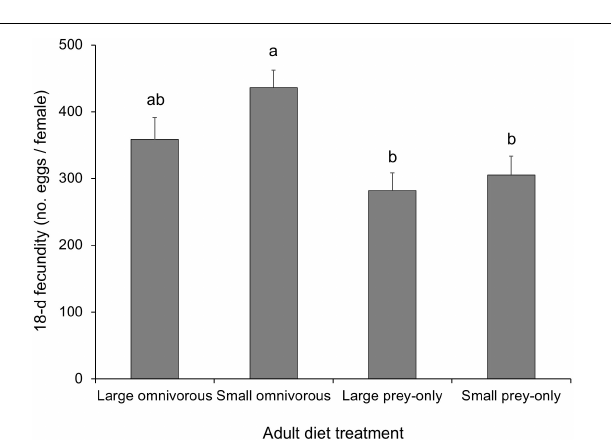
FIGURE 2 | Mean (+ SE) number of oviposition days (no. days on which clutches were laid out of 18 days of observation) for large ( ad libitum larval food access) and small (3 h daily larval food access) Hippodamia convergens pairs subjected to one of two different adult diet treatments: omnivorous (pollen, honey, Schizaphis graminum and Ephestia kuehniella eggs), or prey-only ( S. graminum and E. kuehniella eggs). Treatments bearing the same letter were not significantly different (Tukey’s test, α = 0.05).